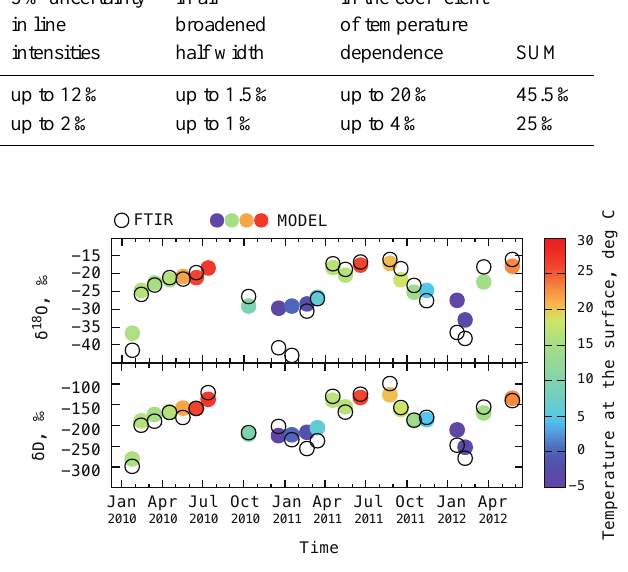
Figure 11. A posteriori calculated values of δ 18 O and δ D averaged during each month of measurements and corresponding ECHAM5- wiso model